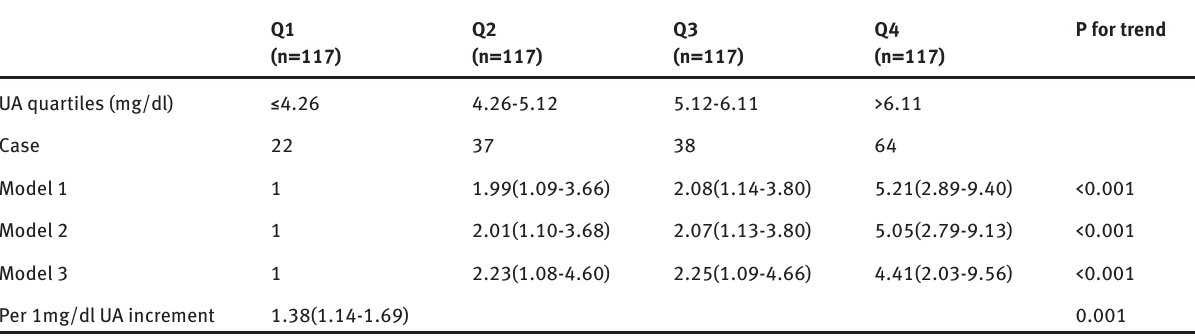
Table 3: Odds ratios (95% CIs) of MetS according to quartiles of